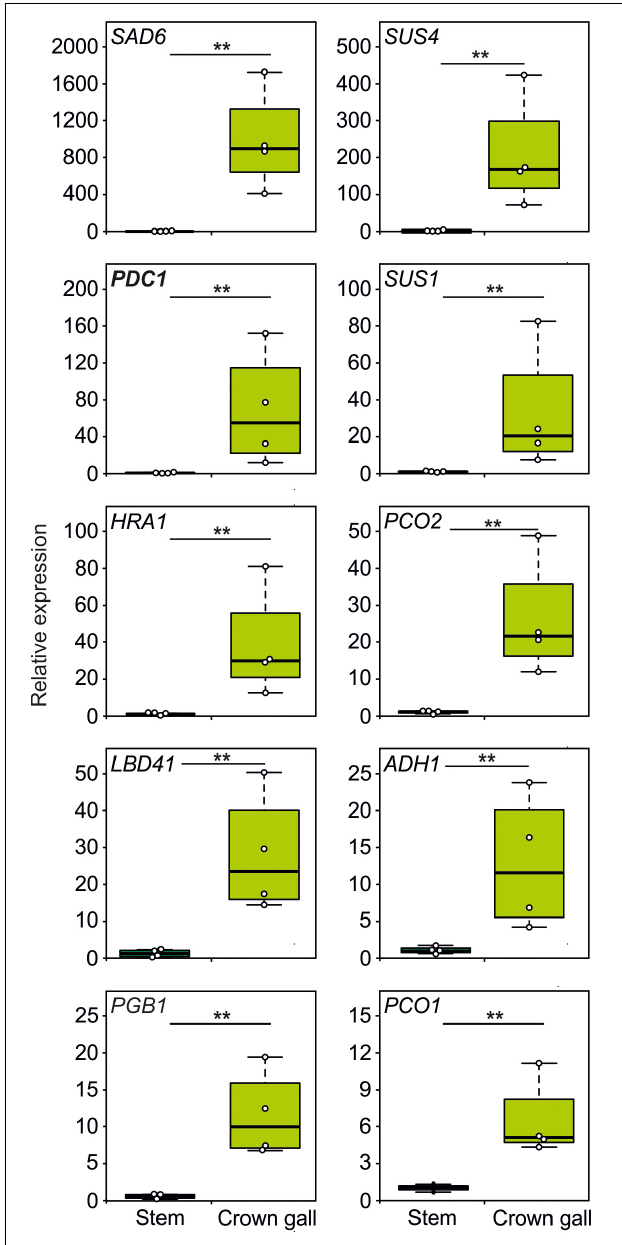
FIGURE 3 | The expression of hypoxia related genes is upregulated in crown gall tumors. Relative expression of hypoxia-responsive genes in crown gall tumors compared with stem tissue inoculated with a non-tumor producing Agrobacterium strain. Data are presented as boxpots. Stars indicate a statistically significant difference [ ∗ < 0.05, ∗∗ < 0.01, ANOVA followed by Holm-Sidak post hoc